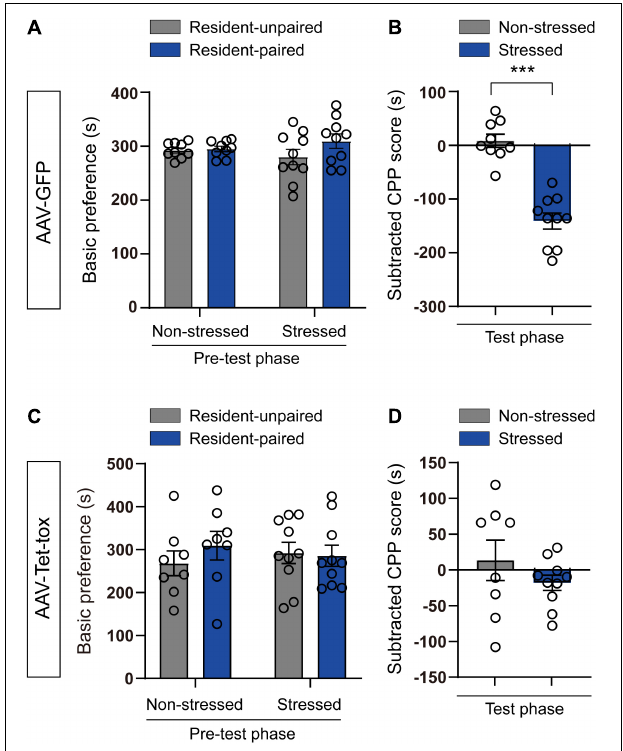
FIGURE 2 | Effect of ZI silencing on RSDS-induced CPA. (A,C) The basic preference of mice for the CPA apparatus were examined in pre-test phase. The mice in all groups did not exhibit an innate preference for the CPA apparatus. The two-tailed paired t -test was used to compare the preference score of mice in resident-unpaired and resident paired chambers. (B,D) The subtracted CPP score was recorded in test-phase. The stressed mice in AAV-GFP group showed marked aversive effects to the resident-paired chamber, whereas the stressed mice in AAV-Tet-tox group showed less marked aversive effects. The two-tailed unpaired t -test was used to compare the subtracted CPP score of mice in non-stressed and stressed groups. *** P <